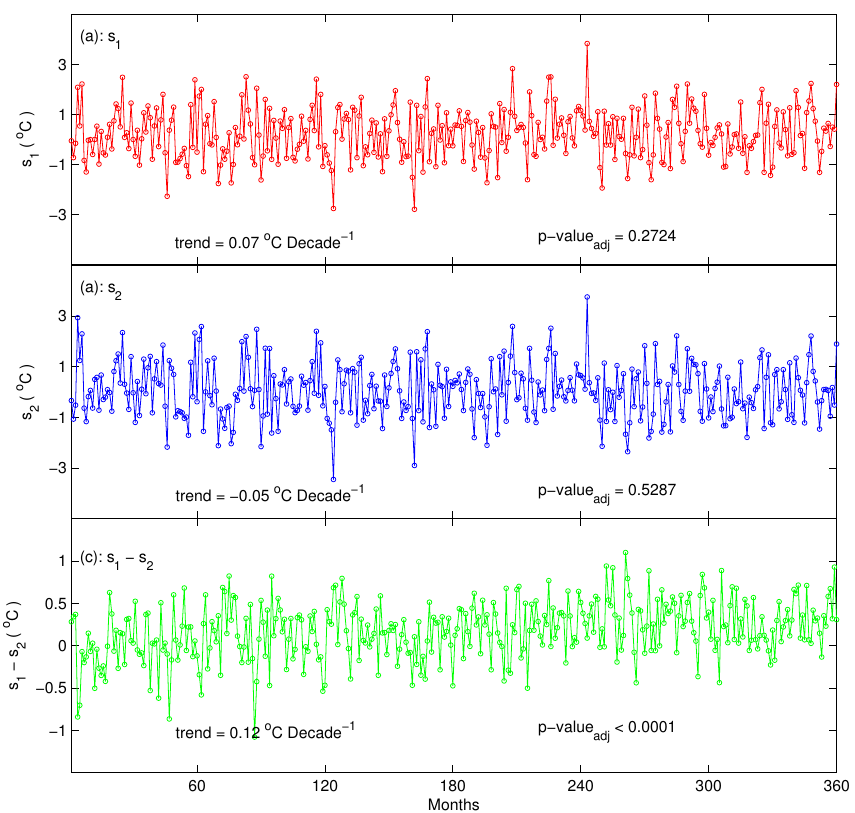
Figure A1. An example of two non-significant trends in s 1 (a) and s 2 (b) temperature time series individually but differentiating them, s 1 – s 2 temperature series (c) shows a significant trend. This is one realization example taken from the simulations; s 1 and s 2 were constructed with trend values of 0.12 and 0.00 ◦ C decade − 1 ,